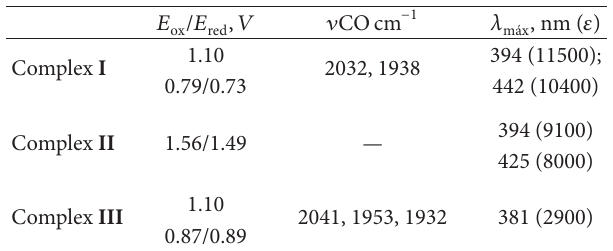
T 2: Electrochemistry properties of complexes I , II, and III in CN. CH 3